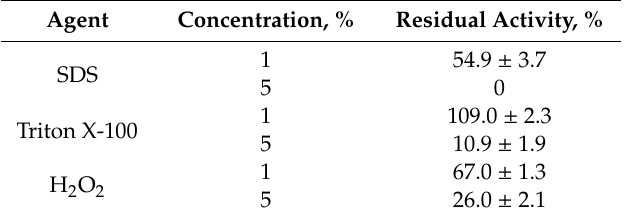
Table 3. E ff ect of bleacher and detergents on BlpLc Table 3. Effect of bleacher and detergents on BlpLc activity.